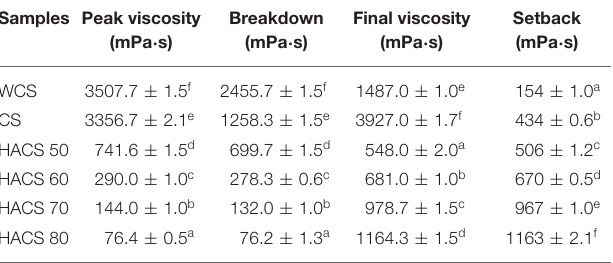
TABLE 2 | Gelatinization characteristic value of corn starch with different amylose content. Samples Peak viscosity (mPa ·